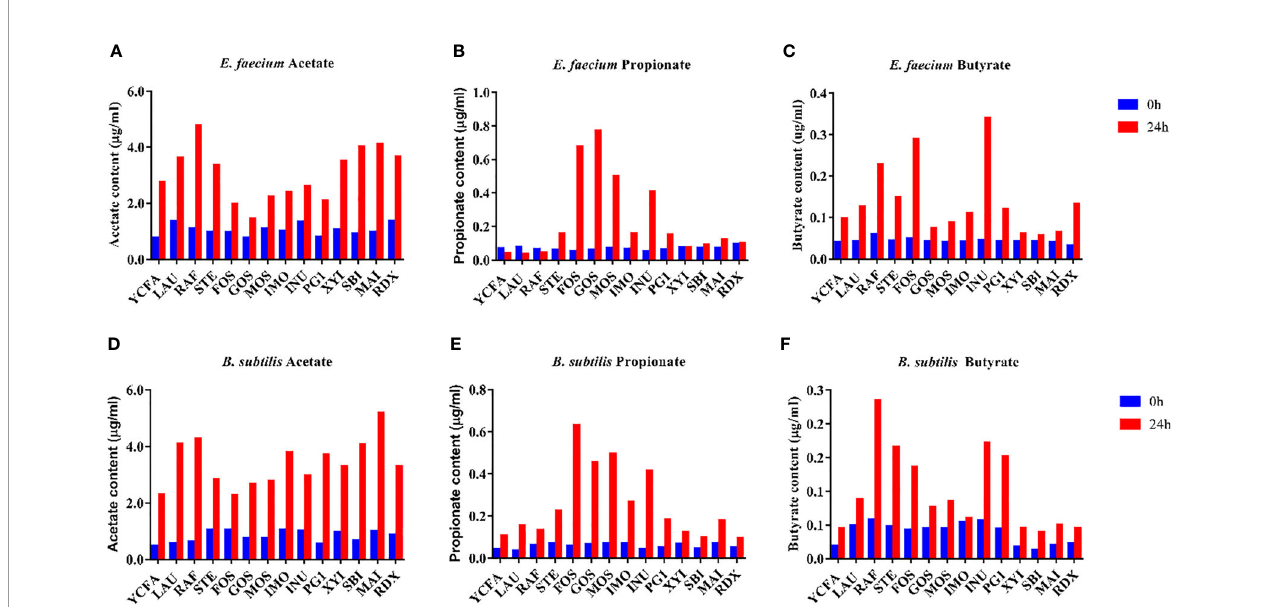
FIGURE 2 | Short-chain fatty acid (SCFA) content after culture of Enterococcus faecium (A – C) and Bacillus subtilis (D – F) with different oligosaccharides after 24 h fermentation. basal medium (YCFA), fruto-oligosaccharides (FOS), lactulose (LAU), raf fi nose (RAF), stachyose (STE), galacto-oligosaccharides (GOS), mannose- oligosaccharides (MOS), isomalto-oligosaccharide (IMO), inulin (INU), polyglucan type 1 (PG1), xylitol (XYI), sorbitol (SBI), mannitol (MAI), resistance dextrin (RDX).